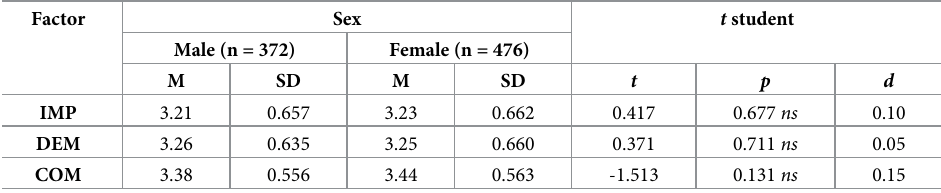
Note: p = significance ; ns = not significant; d = Cohen’s d; IMP = Importance; DEM = Demand; COM =